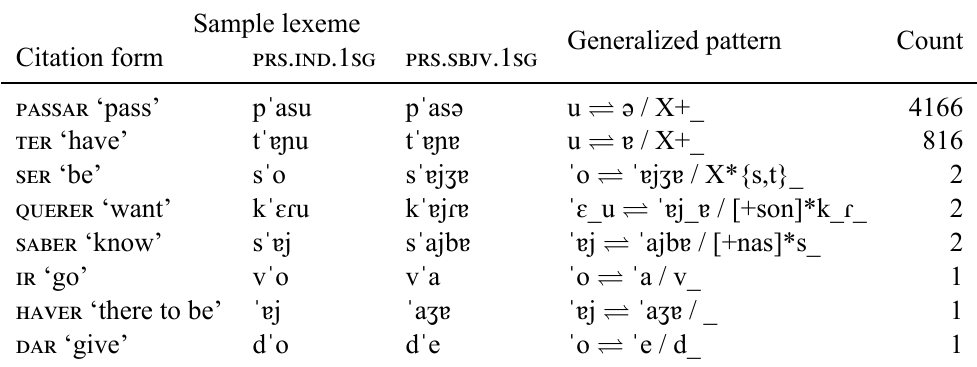
Table 7: Patterns of alternation between the PRS.IND.1SG and PRS.SBJV.1SG , with minimal generalisation over contextual phonotactic